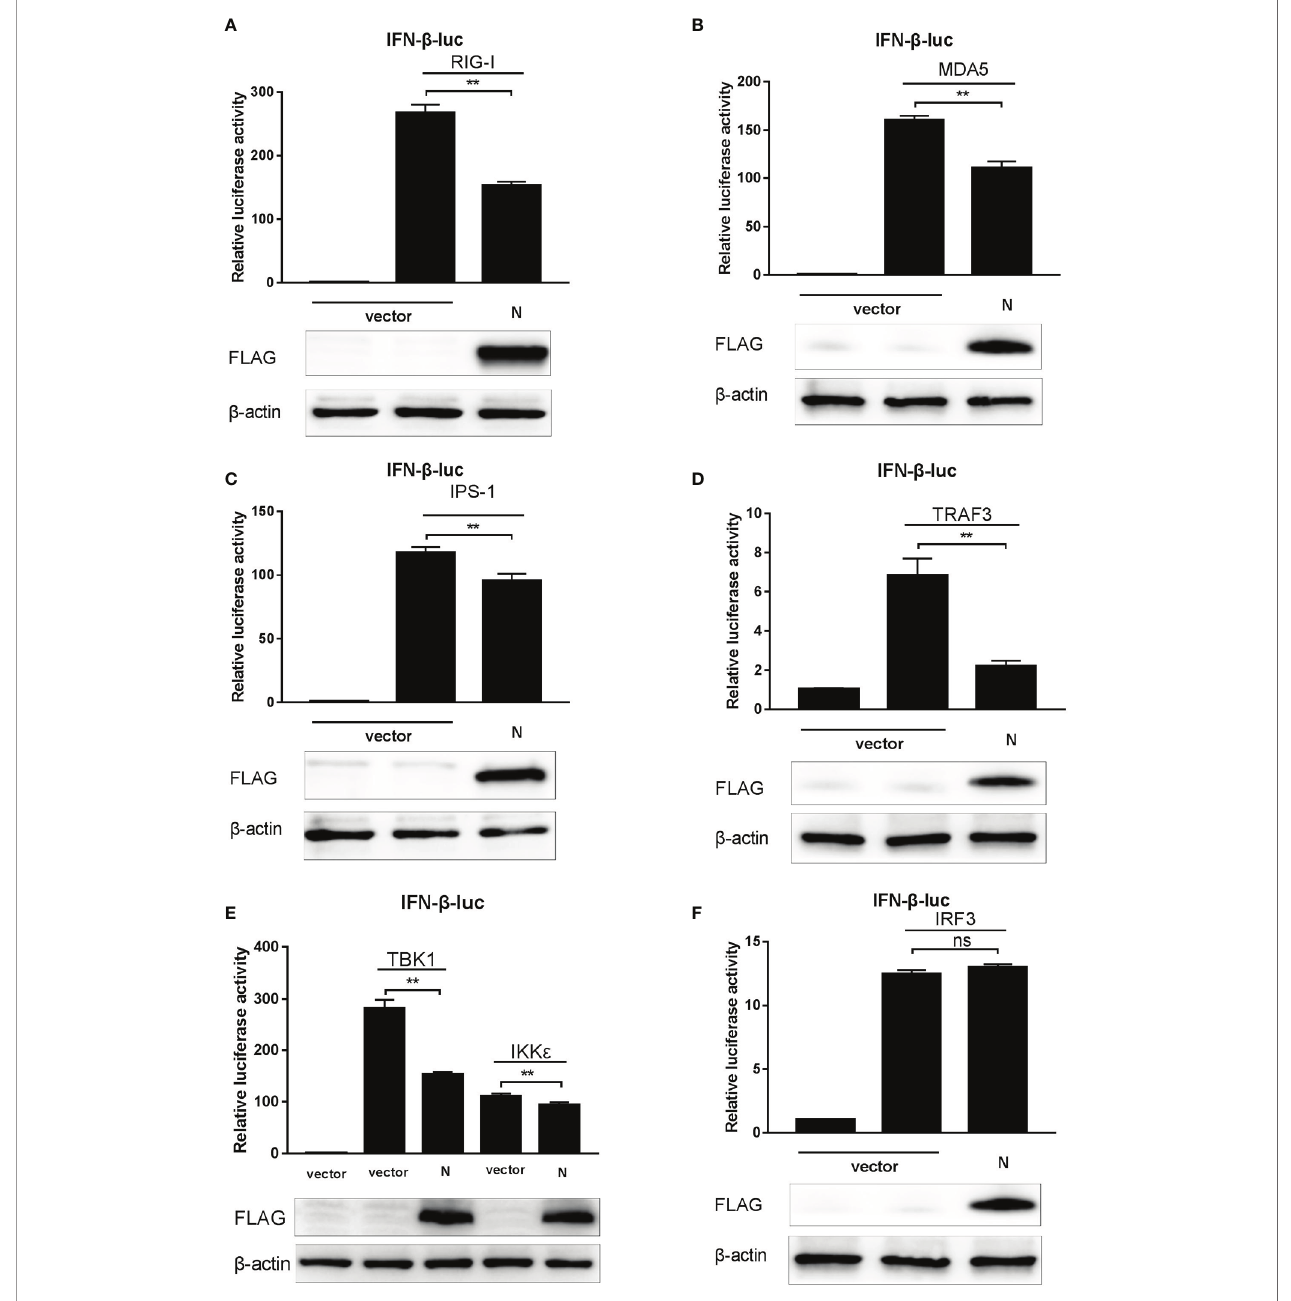
FIGURE 3 | SADS-CoV N protein suppresses the RLRs signaling pathway. (A – F) pCMV-FLAG-N and a series of expression plasmids encoding the RLRs ’ signaling pathway adaptors (RIG-I, MDA5, IPS-1, TRAF3, IKK ϵ , TBK1, and IRF3), together with a luciferase reporter plasmid IFN- b -Luc and the internal control plasmid pRL- TK were co-transfected to HEK-293T cells. After 24 h, cell lysates were collected using a passive lysis buffer, and the relative activity of the IFN- b promoter was measured with the Dual-luciferase assay. Or cell protein lysates were collected using RIPA lysis buffer, and the expression of SADS-CoV N protein and b -actin (as the loading control) was detected by Western blot. ** P < 0.01; ns, nonsigni fi cant differences in